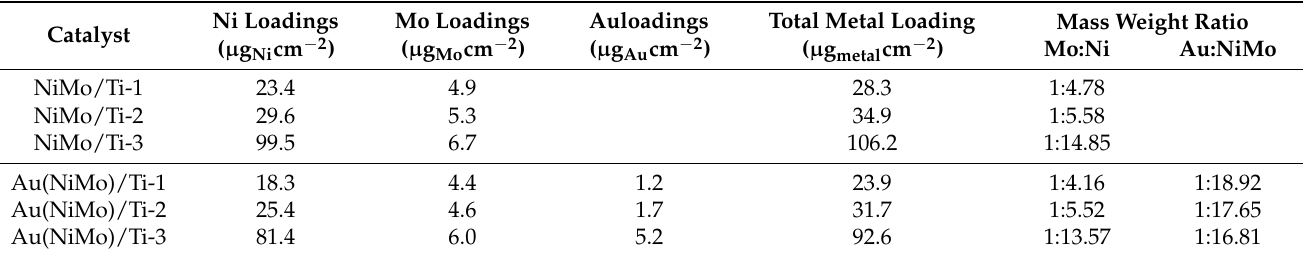
Table 2. The metal loading in the catalysts was determined by ICP-OES analysis and metal mass weight